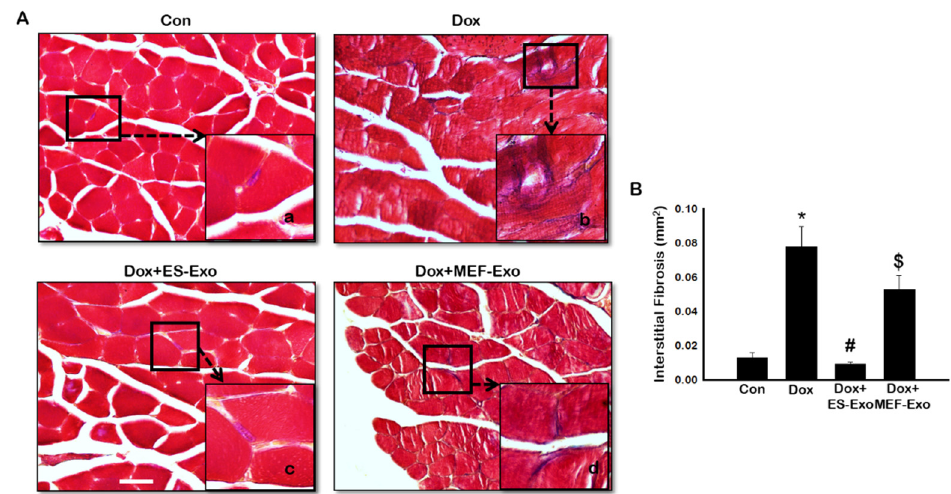
Figure 13. ES-Exos treatment inhibits Dox-induced fibrosis in the soleus muscle. ( A ) Representative Masson’s trichrome images showing interstitial fibrosis in transverse soleus sections. Each box shows Control ( a ), Dox ( b ), Dox + ES-Exo ( c ), and Dox + MEF-Exo ( d ). ( B ) Percentage of interstitial fibrosis quantified over the total muscle cell area. Error bars = mean ± S.E.M. * p < 0.05 vs. control, # p < 0.05 vs. Dox, $ p = non-significant vs. Dox, one-way ANOVA followed by Tukey test; Scale bar = 100 µm, n = 14–16 (male and female). Images taken at 40 × magnification.